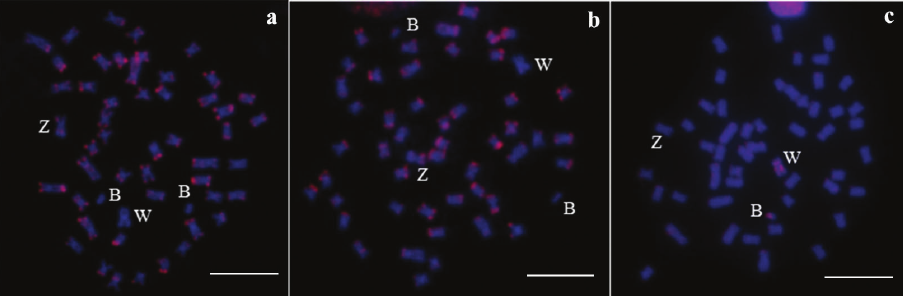
Figure 5. Mitotic metaphases after FISH with the microsatellites. a (GA) Note the accumulation of (GAG) 10 in the B and W